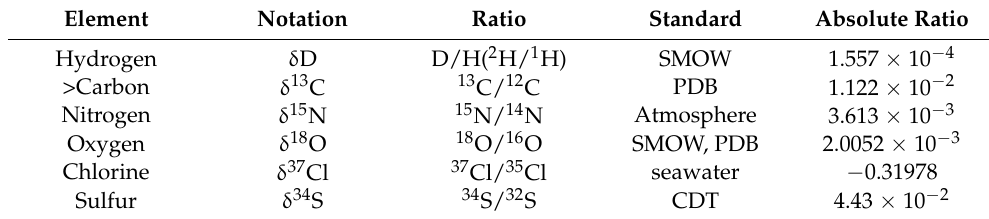
Table 1. Isotopic ratios of stable isotopes [21].